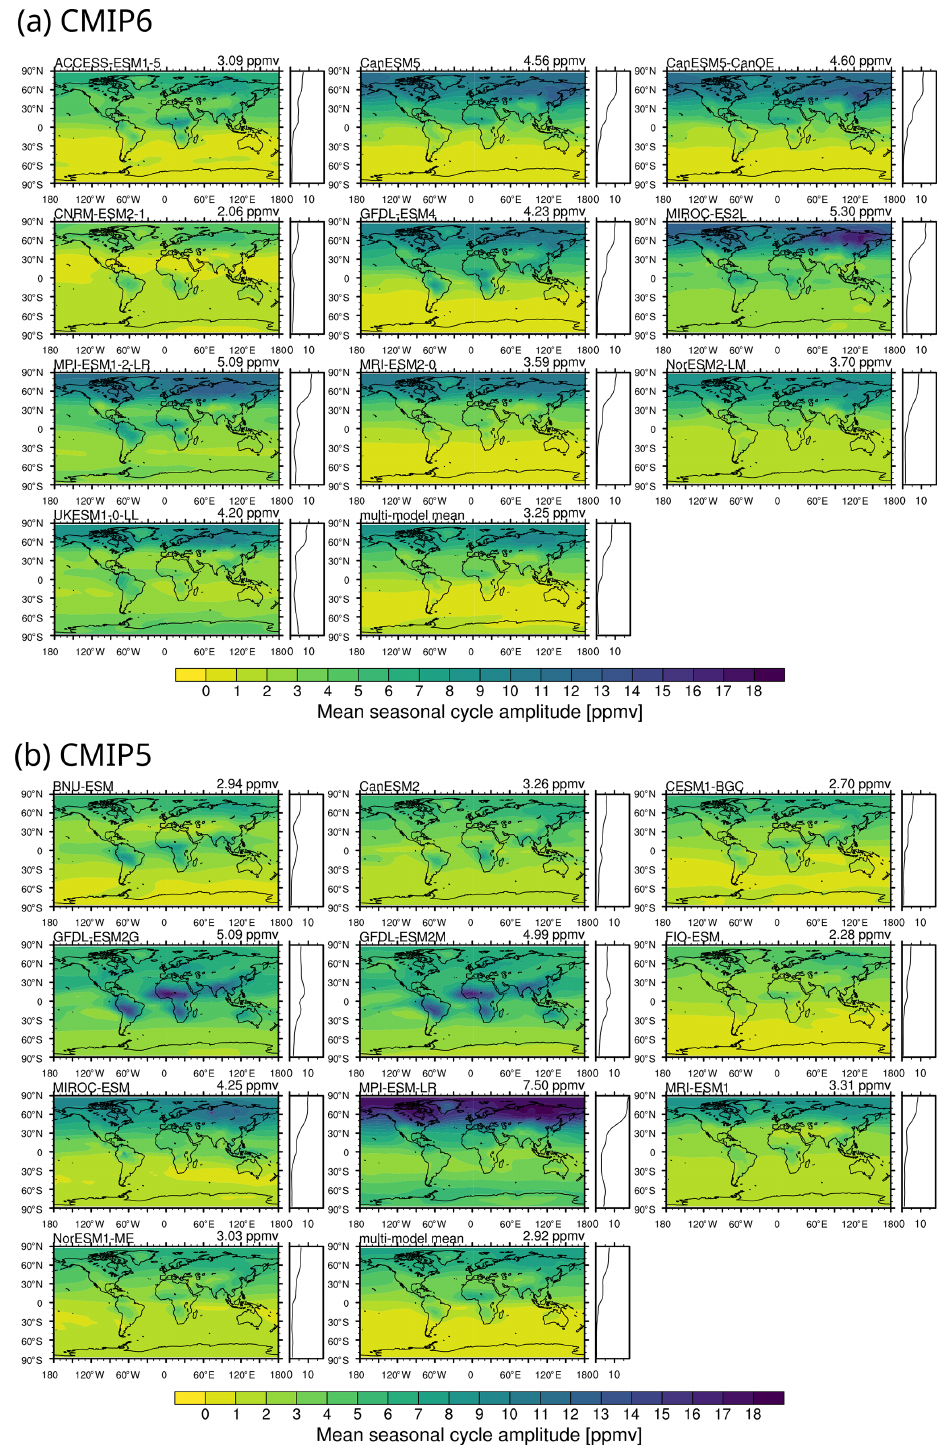
Figure 5. Maps of mean annual seasonal cycle amplitude for 2003–2014 for the CMIP6 (a) and CMIP5 (b) models. The model name is given in the top left of each panel, and the top right shows the global average of the mean annual seasonal cycle. The panel to the right of the maps shows the same zonal mean